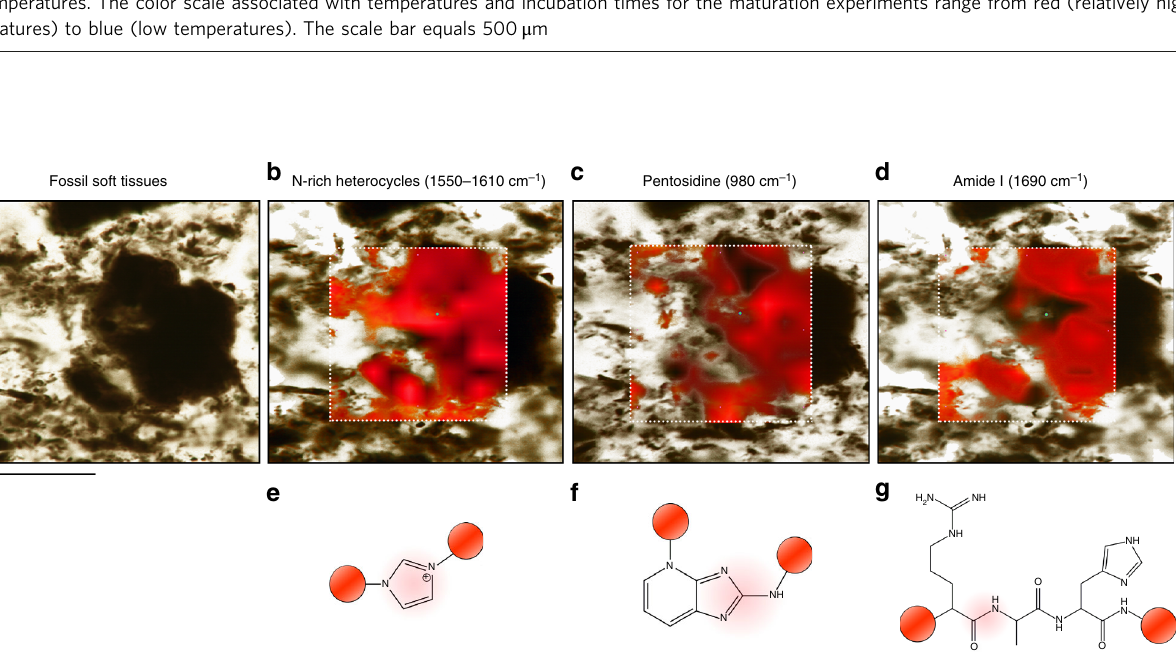
Fig. 3 High-resolution Raman maps (3 s exposure time, 3 accumulations) of remains of extracellular matrix extracted from Allosaurus fragilis bone in aqueous hydrochloric acid (pH = 3). The dotted rectangles mark the area mapped, and the different shades of red represent the signal intensity of the protein fossilization product (PFP). The colored spheres framing the compound structures represent a N-heterocycle polymer context, and the red shading labels the functional unit that gives rise to each signal mapped out. The scale bar equals 300 μ m. a Dark residue of soft tissue. b Map of N-rich heterocycles (1550 – 1610 cm − 1 ), which cover most of the sample surface. c Pentosidine (980 cm − 1 ), the AGE marker, which corresponds to the spatial distribution of N-rich heterocycles. d Amide I generated by peptide bonds, which is a less precise match for the N-rich heterocycles (1690cm − 1 ). e – g The organic functional units representing the selected Raman shifts are shaded (red) below each map